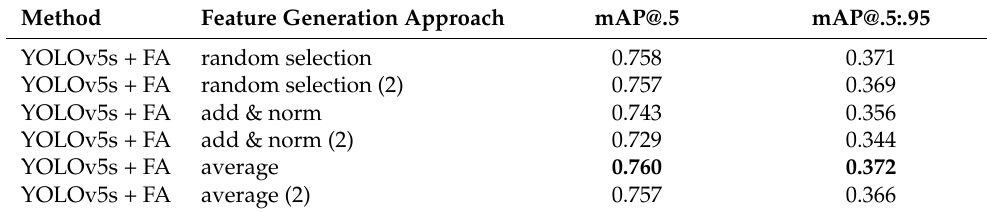
Table 4. Evaluation of support feature generation approaches.